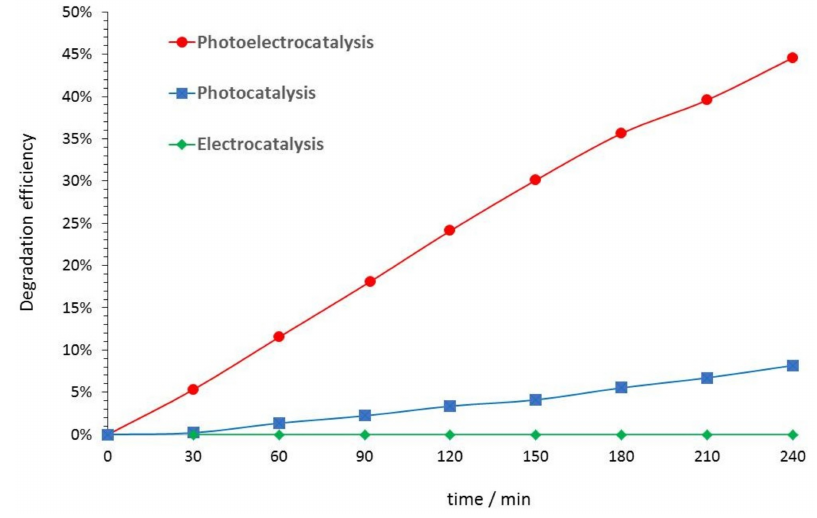
Figure 2. Monitoring of the photoelectrocatalytic, photocatalytic, and electrocatalytic degradation of acetaminophen by means of absorbance measurements with an ultraviolet-visible spectrophotometer. The photocatalyst was anodized at a Re of 600 (length = 6.1 µ m), and the pH value was